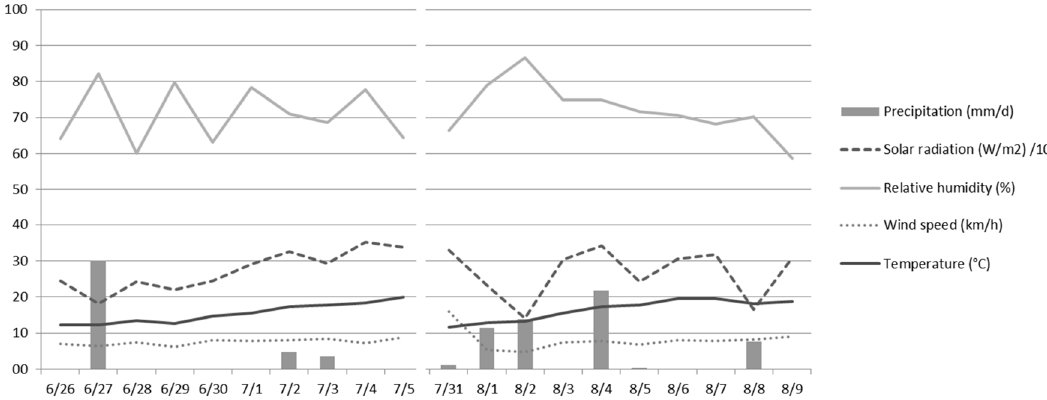
Figure 1. Weather conditions during the two experimental periods.